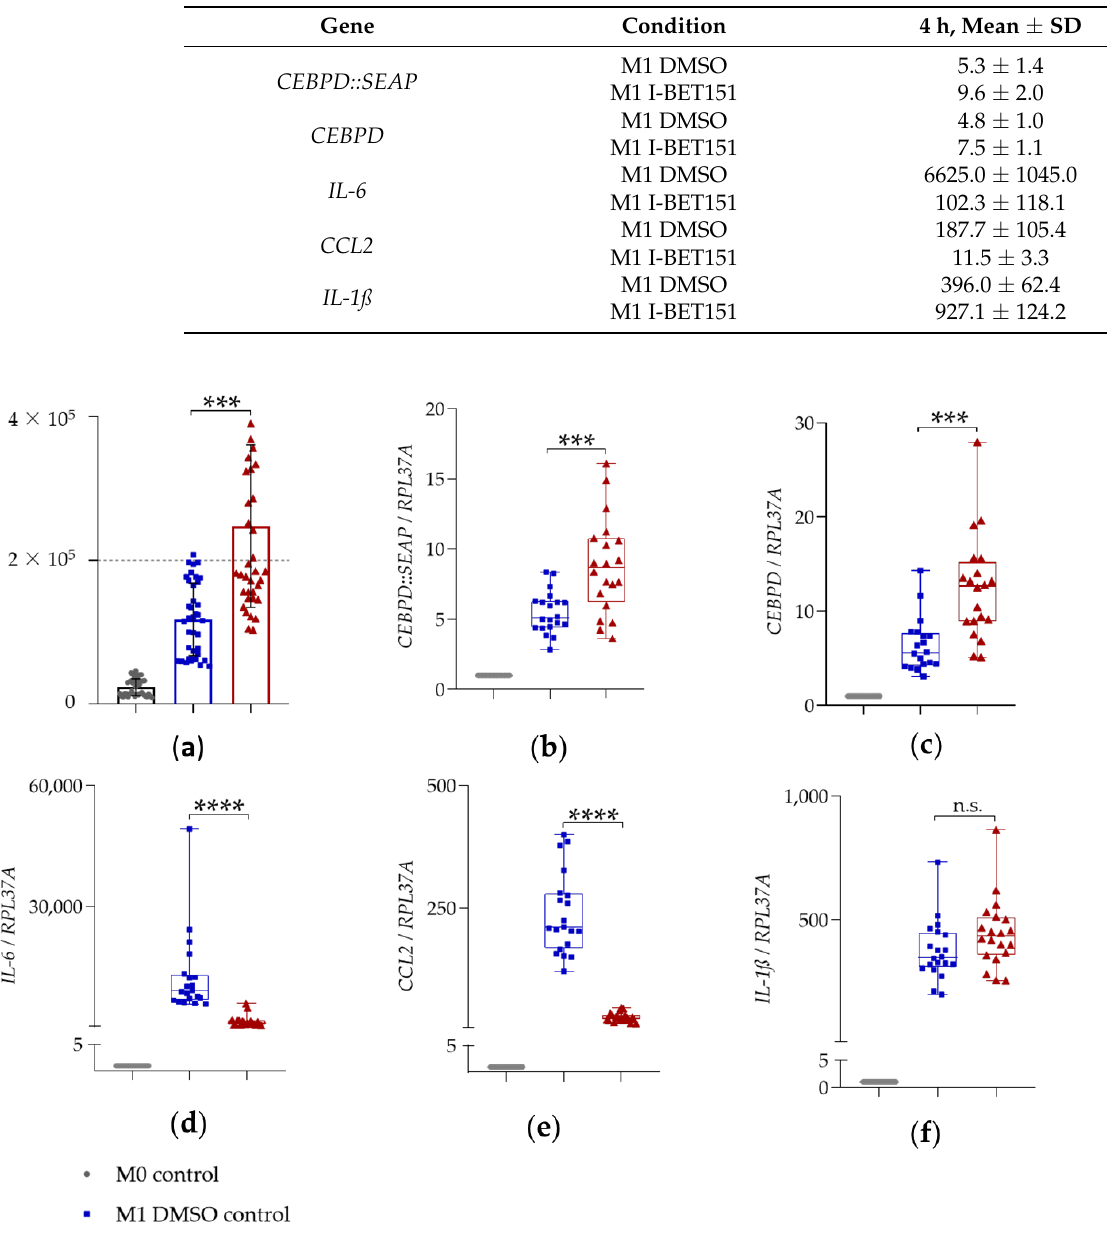
Table 3. Fold change (mean ± SD) for mRNA expression in Ro 11-1464-pre-treated target cells compared to M0 controls ( compare Figure 5).